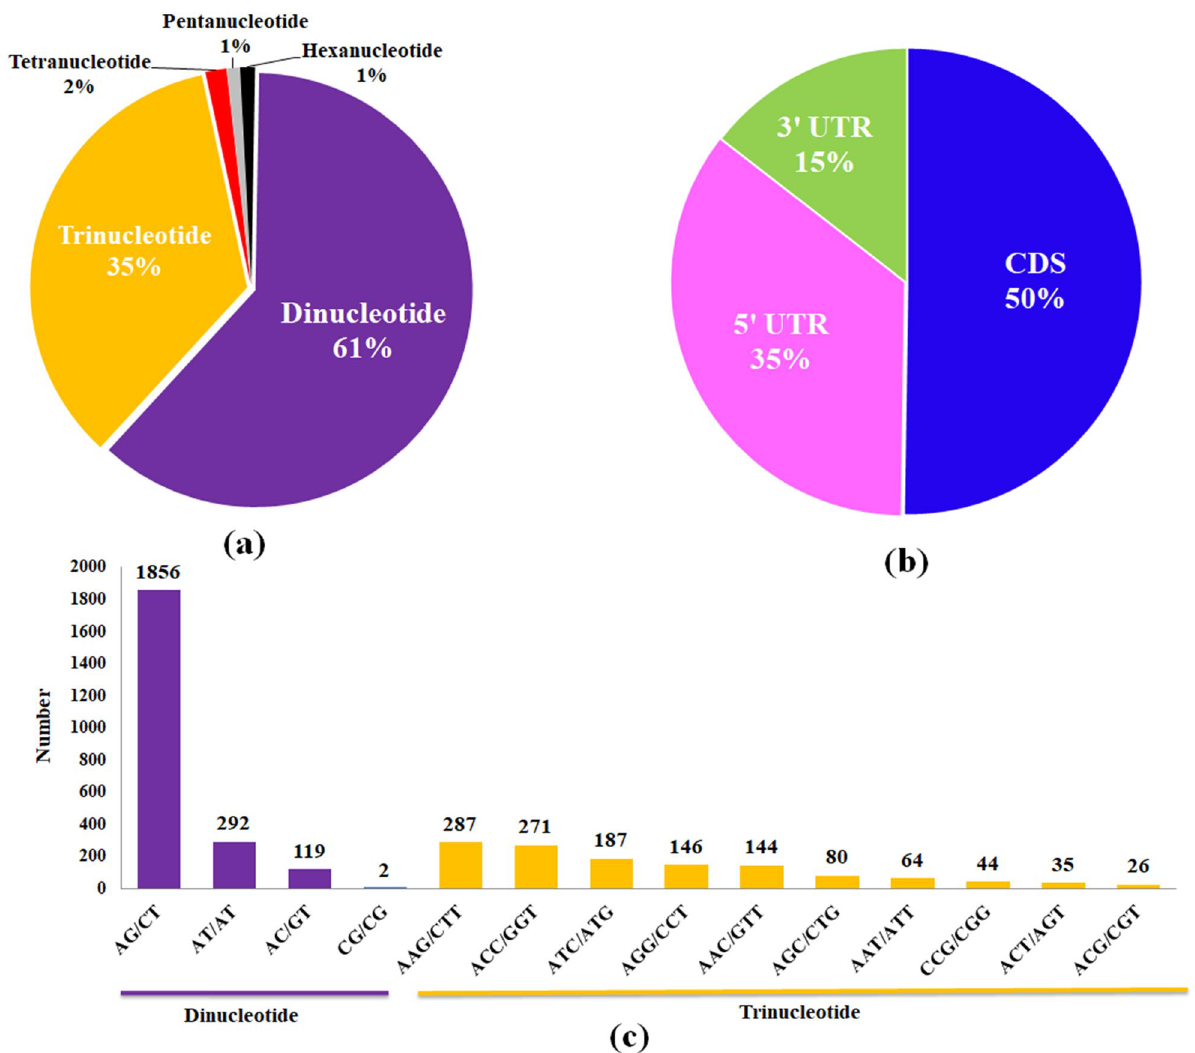
Figure 1. Abundance and localization of various SSRs transcription factors in tea: ( a ) Overall abundance of various SSR repeats; ( b ) Localisation of SSR repeats in CDS and UTRs; ( c ) Distribution frequency of major repeat motif